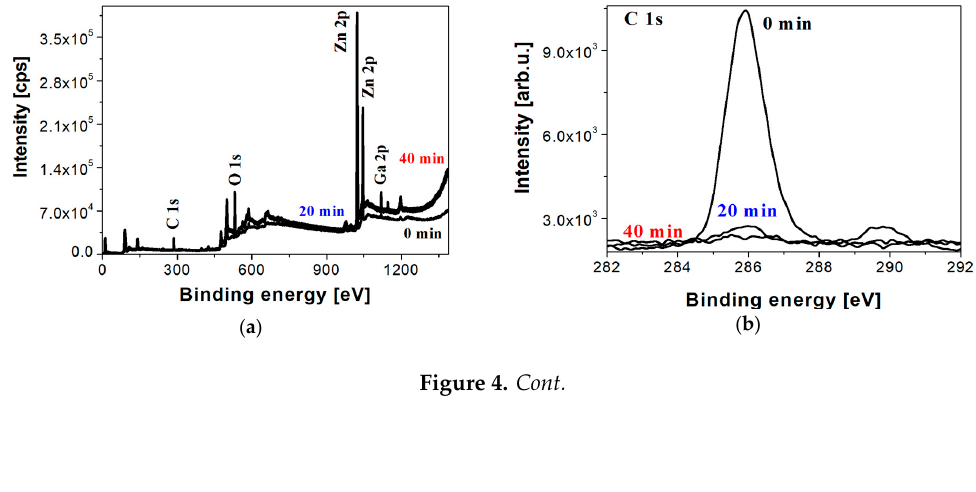
Figure 3. 3D topography of ZGO films with the corresponding root mean square (RMS) roughness and sputtering voltage: ( a ) RMS roughness 16.77 nm, 0.5 kV; ( b ) RMS roughness 15.56 nm, 0.9 kV and ( c ) RMS roughness 12.90 nm, 1.1 kV.